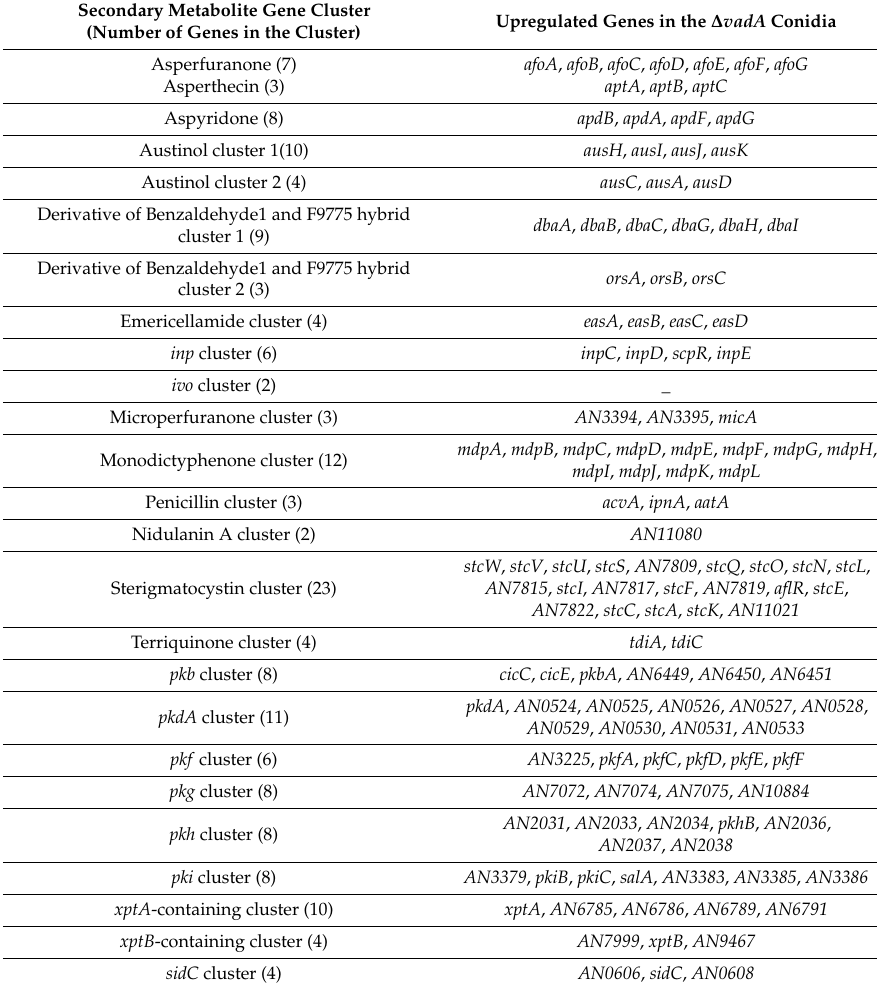
Table 1. Upregulated genes in secondary metabolite genes clusters in the ∆ vadA conidia. Secondary Metabolite Gene Cluster Upregulated Genes in the ∆ vadA (Number of Genes in the Cluster)